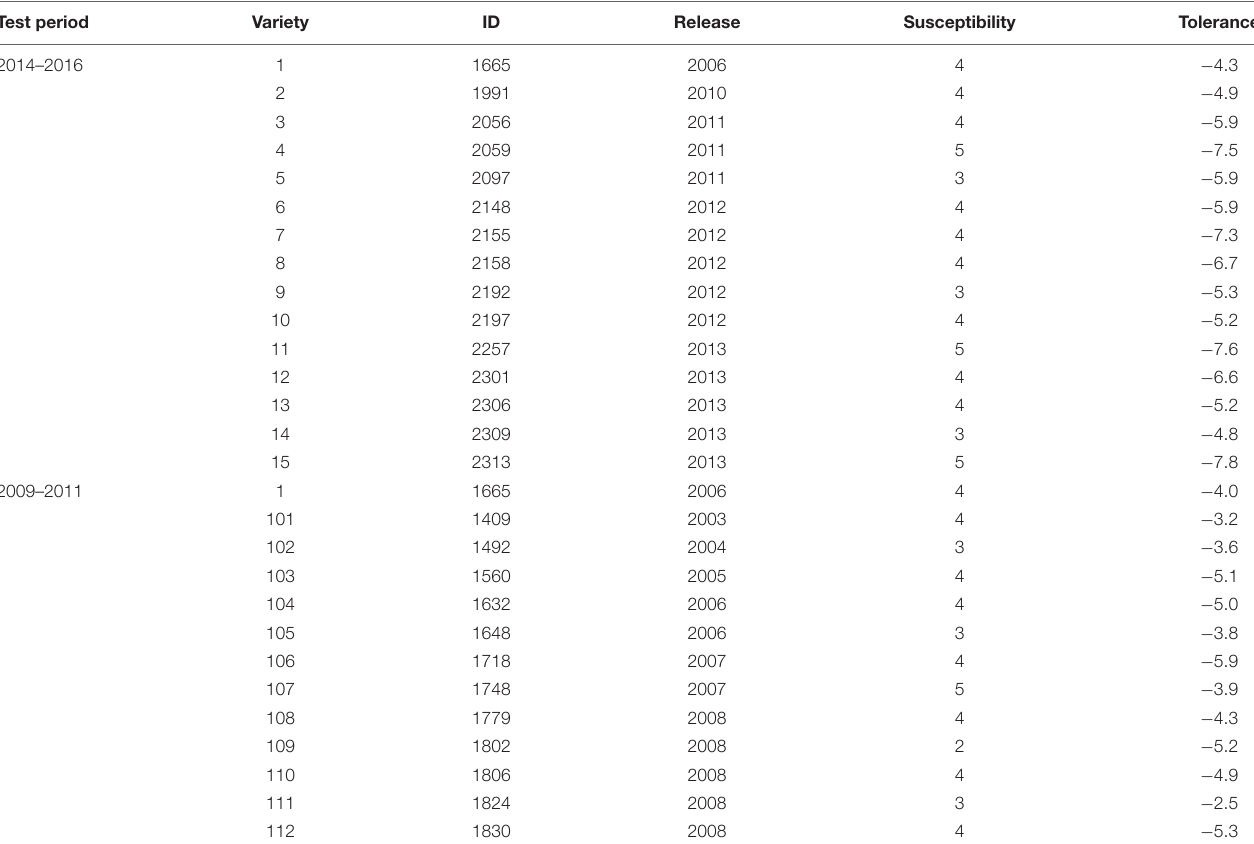
TABLE 1 | Sugar beet varieties tested in national variety trials in Germany 2014–2016 and 2009–2011. Test period